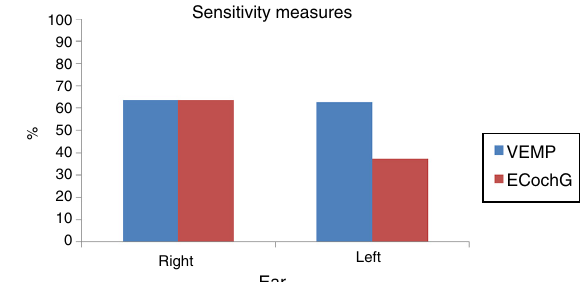
Figure 3 VEMP and ECochG specificity in the right and left ears.